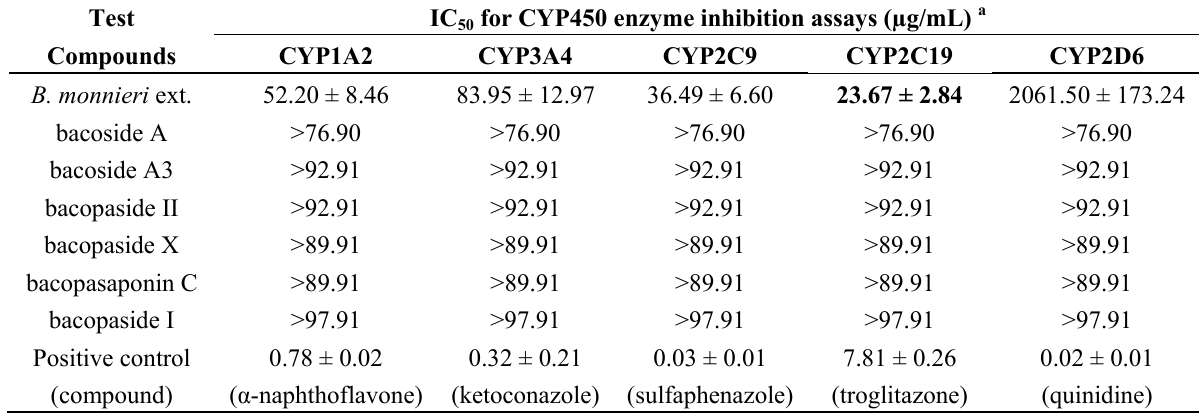
Table 1. B. monnieri extract, but not its identified constituents, inhibit CYP450 enzymes in a moderate fashion. Inhibition on CYP2C19 was found to be most